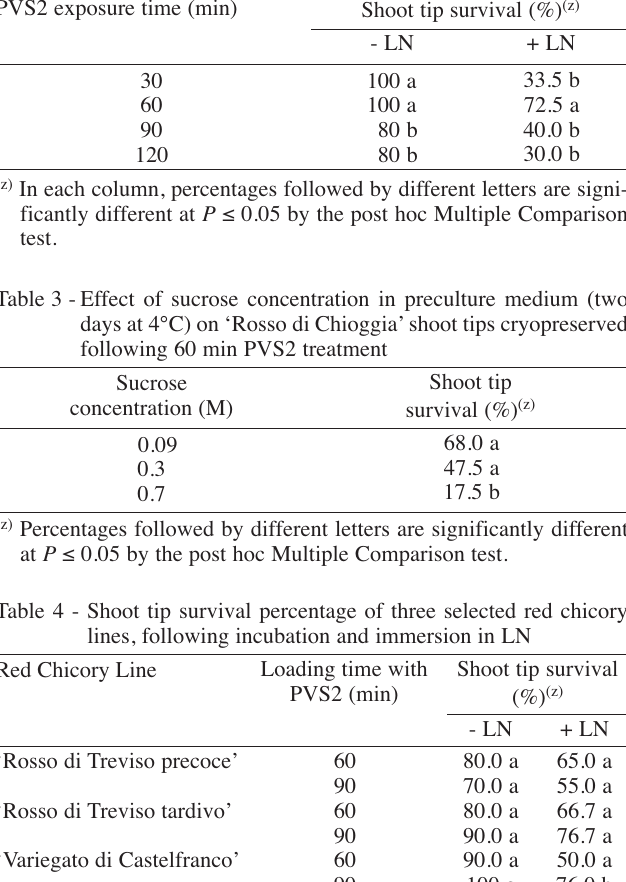
Table 5 - Effect of recovery media on ‘Rosso di Chioggia’shoot tip sur- vival (three weeks) and regrowth (six weeks) after thawing Recovery medium